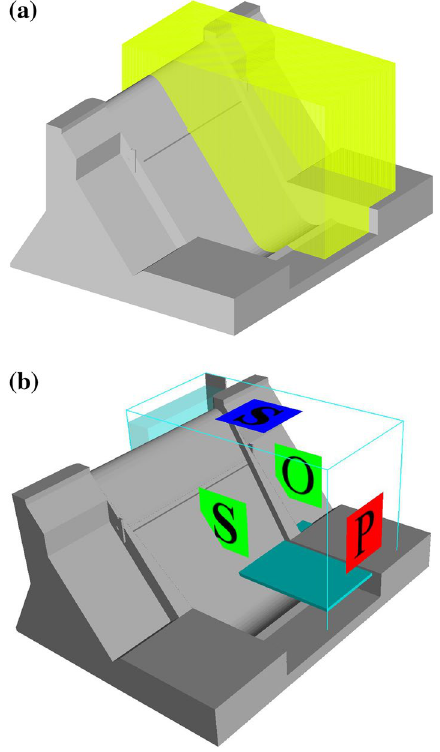
Fig. 3 a Geometry and network. b Boundary and initial conditions of the numerical